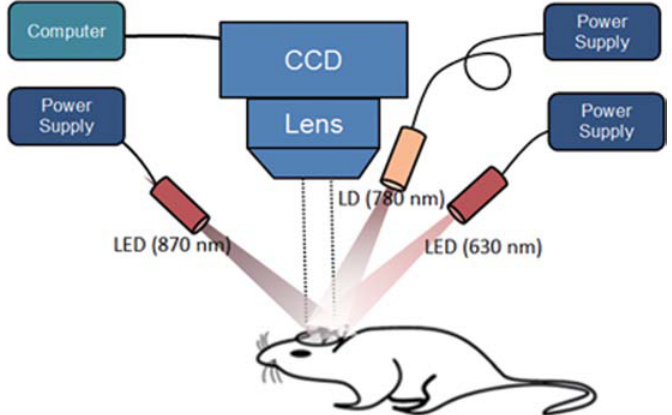
Fig. 1. Illustration of dual-modal optical